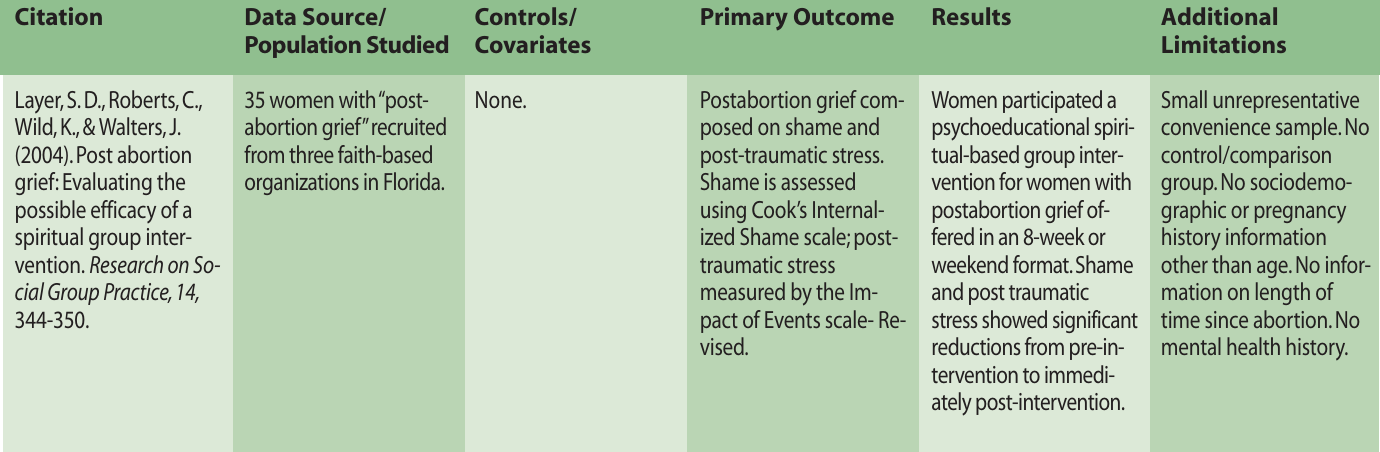
Table 5: U.S.Samples of Abortion Group(s) Only/No Comparison (continued)